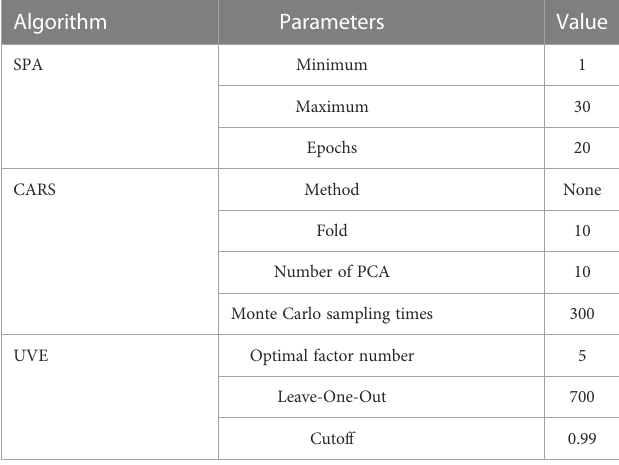
TABLE 2 The parameters of feature band selection